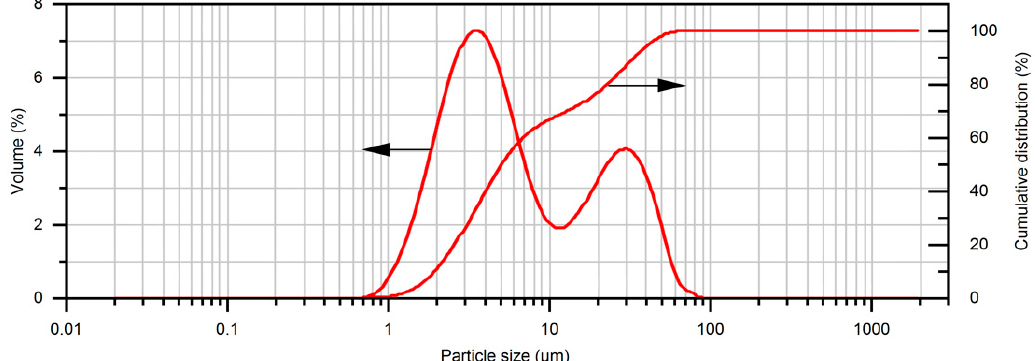
Figure 2. Particle size distribution of CuO.